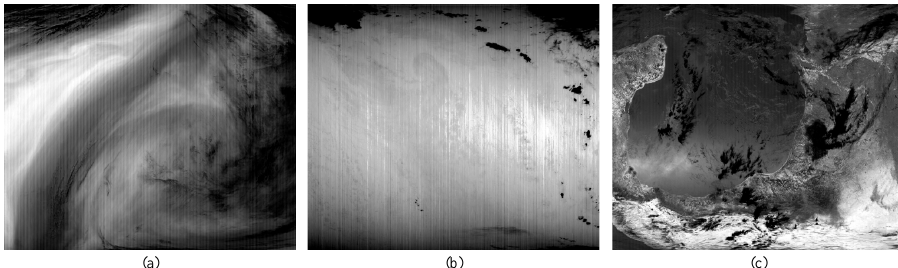
Figure 1. Three typical stripe images of MODIS data. ( a ) Regular stripes in Terra MODIS data band 27; ( b ) Irregular stripes in Terra MODIS data band 34; ( c ) Stripes in Aqua MODIS data band